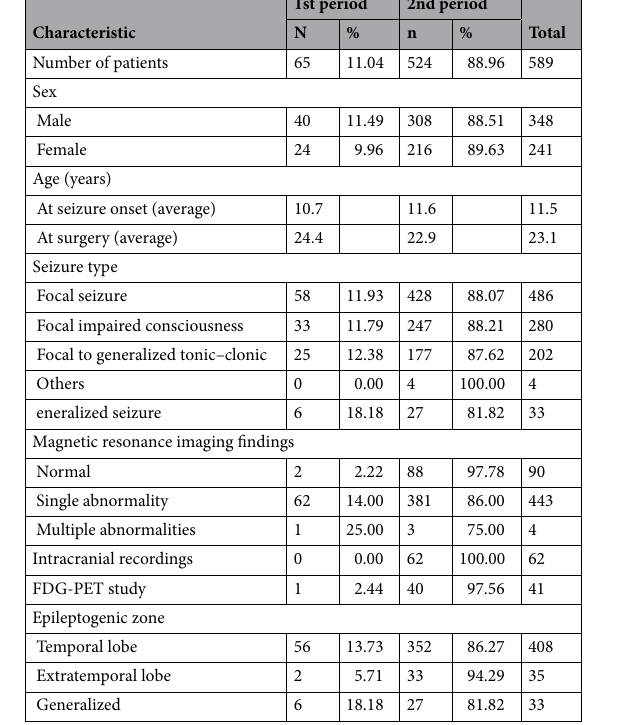
Table 1. Characteristics of patients who underwent epilepsy surgery. FDG-PET Fluorodeoxyglucose-positron emission tomography.